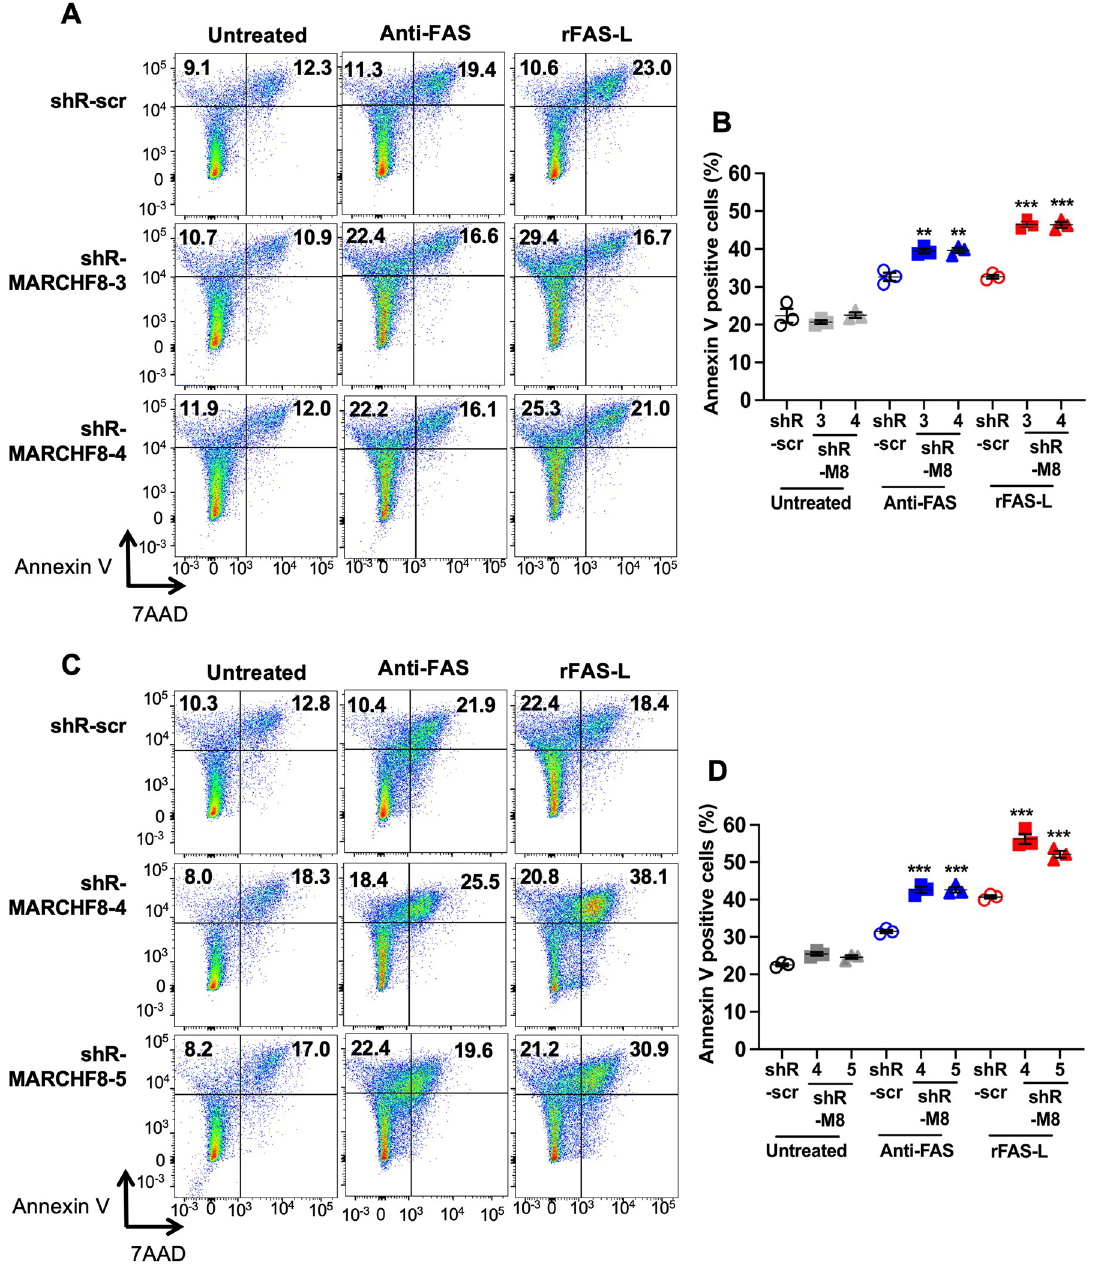
Fig 6. Knockdown of MARCHF8 enhances apoptosis of HPV+ HNC cells. Two HPV+ HNC cells, SCC152 ( A and B ) and SCC2 ( C and D ), with scrambled shRNA (shR-scr) or two shRNAs against MARCHF8 (shR-MARCHF8), were treated with an anti-human FAS antibody (Anti-FAS, clone EOS9.1, eBioscience) or the recombinant FAS ligand (rFAS-L, BioLegend #585404). The cells were stained with an anti-annexin V antibody and 7-AAD and analyzed by flow cytometry. The percentage of cells with positive staining is indicated ( A and C ). The data shown are means ± SD of three independent experiments ( B and D ). P values were determined by Student’s t -test. �� p < 0.01, ��� p < 0.001.